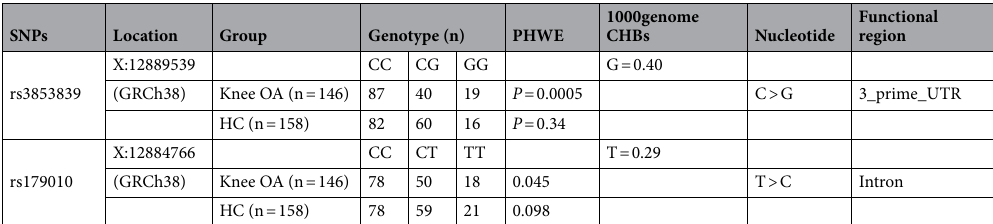
SNPs Location Group Genotype